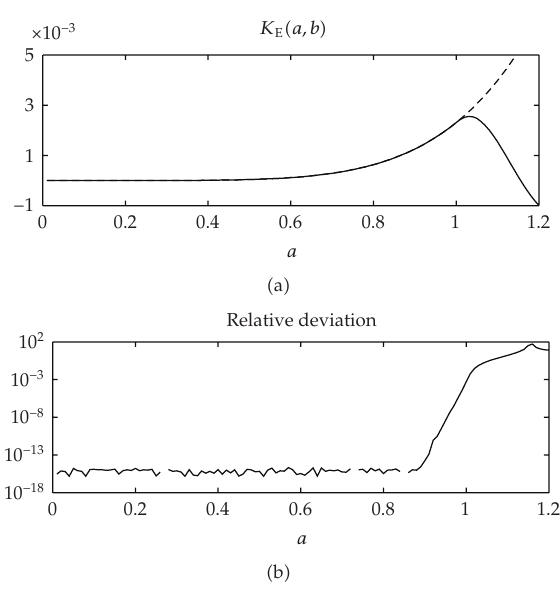
Figure 10: Comparison between the direct series evaluation (cid:2) solid (cid:3) and the analytic representation (cid:2) dashed (cid:3) for the even-order spectra K (cid:6) 3, b (cid:6) 0 . 95 as a is varied. The inset shows the relative E with n di ff erence between the direct series evaluation and the analytic